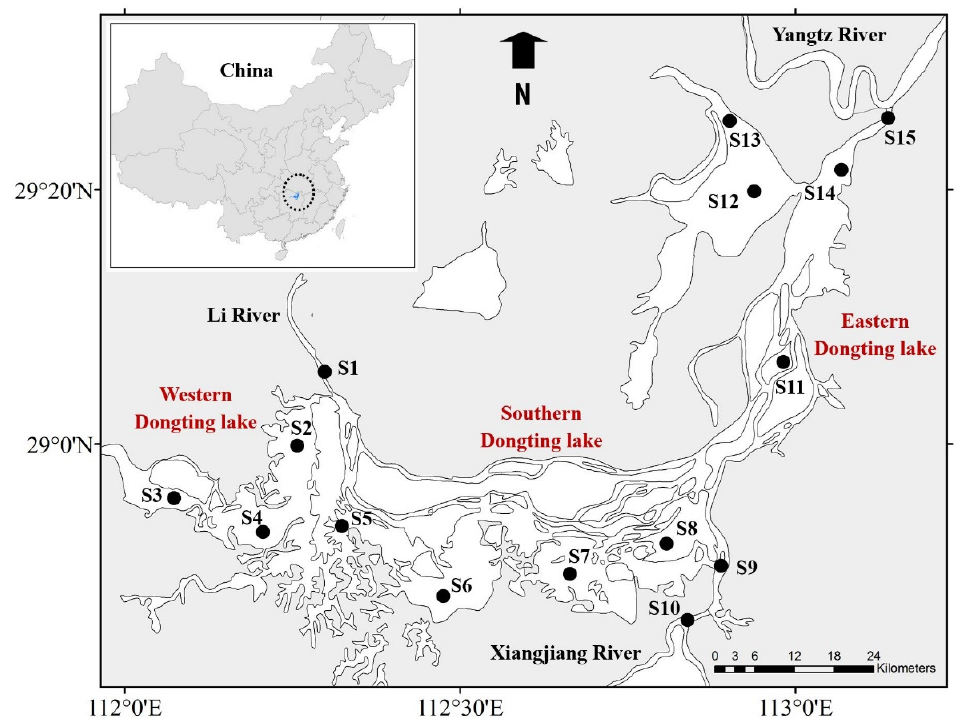
Figure 1. Sampling sites in Dongting Lake. S1: Shahekou; S2: Nanzui; S3: Potou; S4: Jiangjiazui; S5: Xiaohezui; S6: Wanzi Lake; S7: Wanjiazui; S8: Hengling Lake; S9: Yugongmiao; S10: Zhangshugang; S11: Lujiao; S12: East-Dongting Lake; S13: Big-small West Lake; S14: Yueyanglou; S15: Dongting Lake outlet.